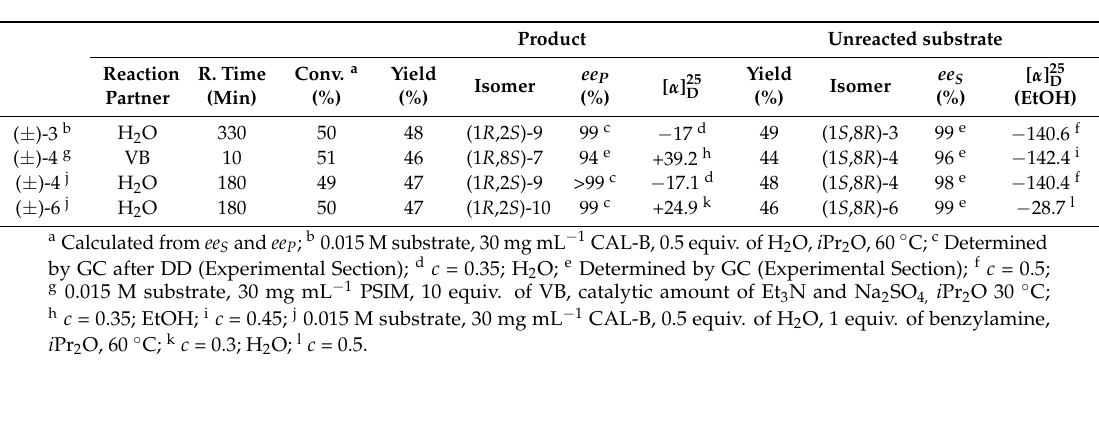
Table 2. CAL-B-catalyzed ring cleavage of racemic 3 a , 4 b , 5 a and 6 b . Table 3. Preparative-scale resolutions.